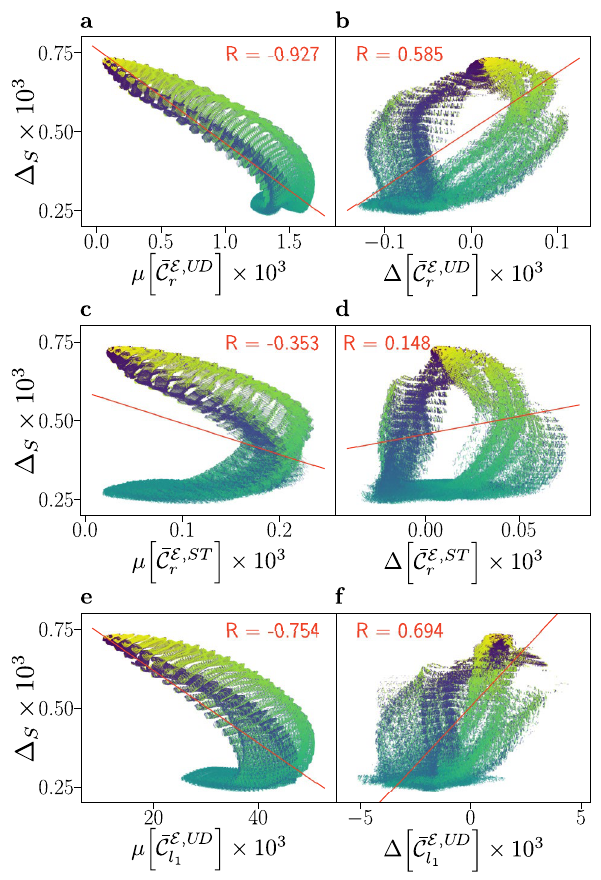
Figure 2. Compass sensitivity, as captured by the anisotropy (cid:31) S , is plotted against electronic coherence measures µ [ ¯ C i ] ( a , c , e ) and (cid:31) [ ¯ C i ] ( b , d , f ), for 878,400 relative orientations of flavin–tryptophan radical pairs. The anisotropy (cid:31) S quantifies the maximal change in the recombination quantum yield as the direction of the applied magnetic field is varied in the frame of the cryptochrome protein, with larger values corresponding to greater sensitivity. Here, we use the recombination weighted relative entropy of coherence ¯ C r defined in Eq. (4), and the l 1 -norm measure ¯ C l 1 defined in Eq. (5) evaluated in the Zeeman basis, also known as the “up-down” (UD) basis, and the singlet-triplet (ST) basis. Coherence is assessed by its mean value µ [ ¯ C i ] as defined in Eq. (8), and difference (cid:31) [ ¯ C i ] as defined in Eq. (9), with respect to the magnetic field directions associated with maximal and minimal recombination yield. Alternative measures are covered in the Supporting Information. Data has been coloured according to the relative orientation angle β , ranging from 0° (blue) to 180° (yellow) and a linear fit (red line) with associated Pearson correlation coefficient R is